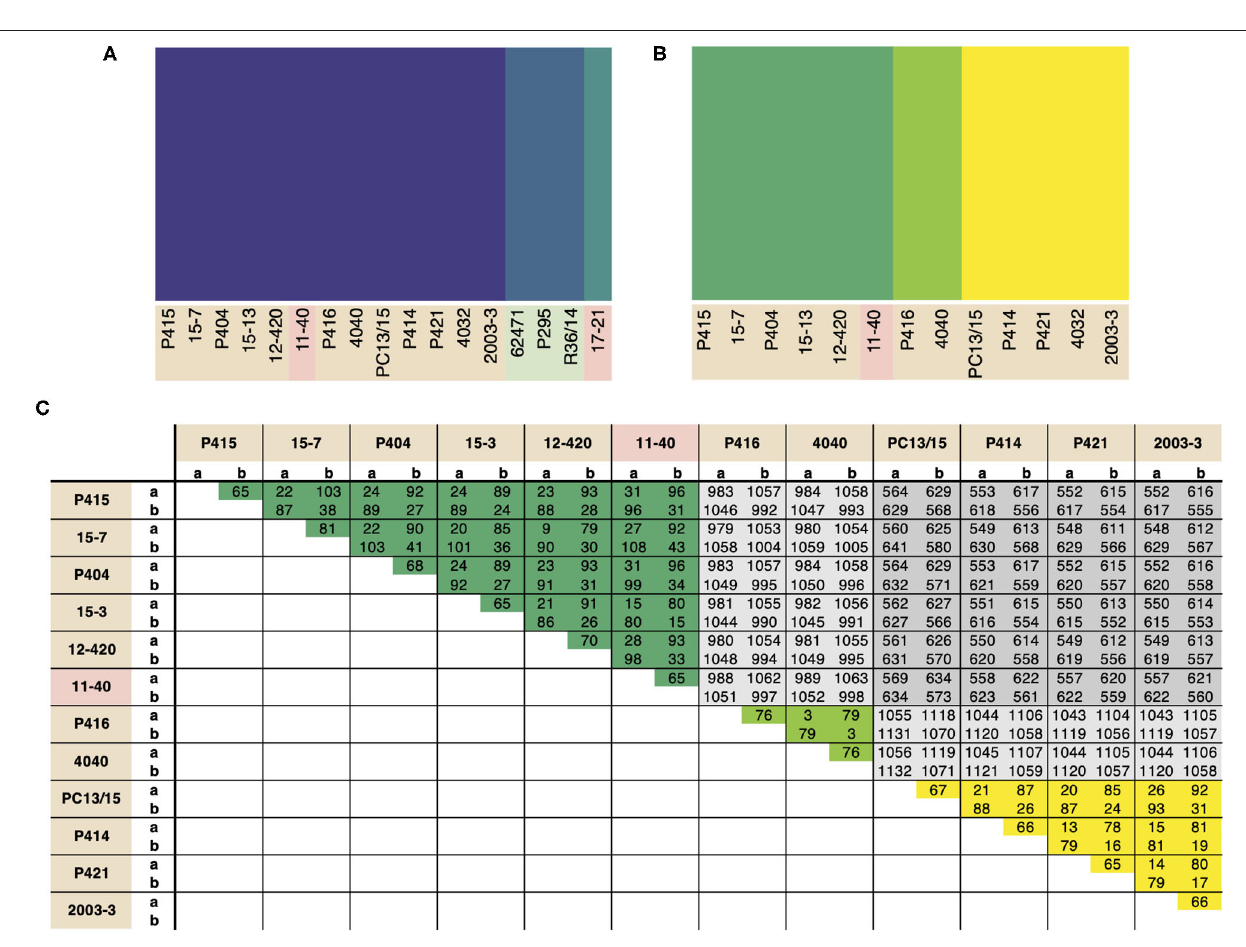
FIGURE 3 | Phytophthora cactorum isolates split into three populations with pre-dominant asexuality. Population analysis of high quality, biallelic SNP sites split the P. cactorum isolates into three populations, admixture of variants was not observed within P. cactorum , or within a single lineage of P. cactorum indicating predominant asexuality. DISTRUCT plot of fastSTRUCTURE ( Raj et al., 2014) results carried out on (A) all sequenced isolates of P. cactorum and (B) strawberry lineage isolates. Data was best described by three “populations” in both datasets. (C) SNP calling was performed in relation to reference isolate P414 for the P. cactorum strawberry lineage. The number of differing sites are shown between the two haplotypes from each isolate; a, representing only homozygous variants and b, representing both homozygous and heterozygous variants in relation to the P414 reference genome. from the U.K., Netherlands, Norway and U.S.A., observed to be distributed throughout the